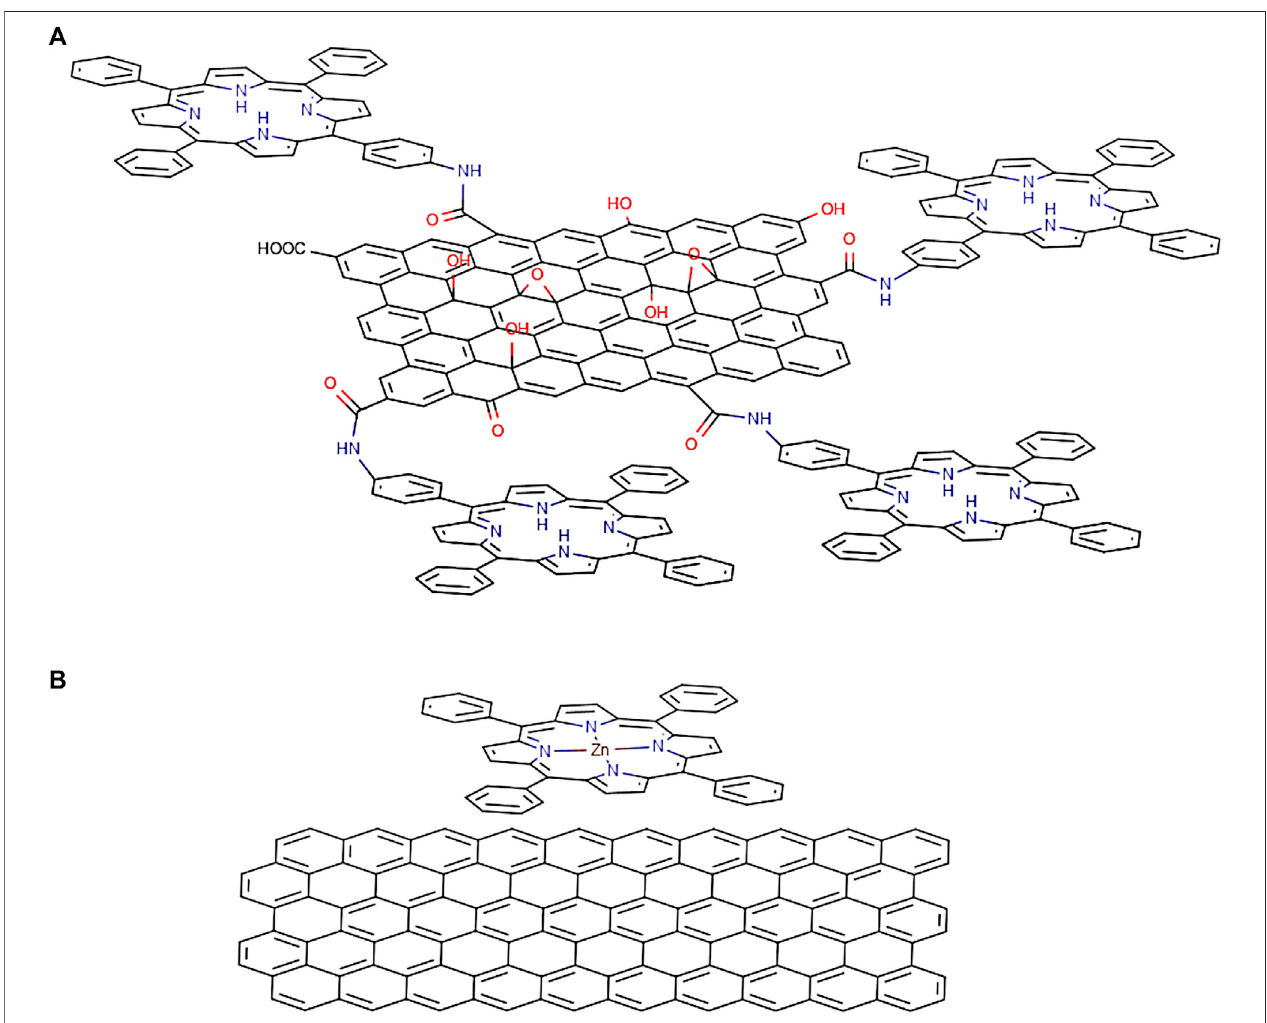
FIGURE 13 | (A) Graphene oxide with covalently linked porphyrins (5-(4-aminophenyl)-10,15,20-triphenyl-21,23 H -porphyrin) (Karousis et al., 2011); (B) the binding of a tetrasulfonated zinc phthalocyanine to graphene via π - π stacking (Zhang and Xi, 2011).